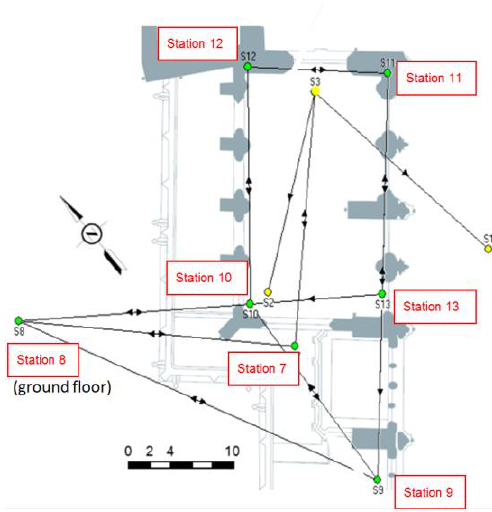
Figure 2. Exemple of a traverse network established around the roof of the Chapel and connected to the ground floor traverse.